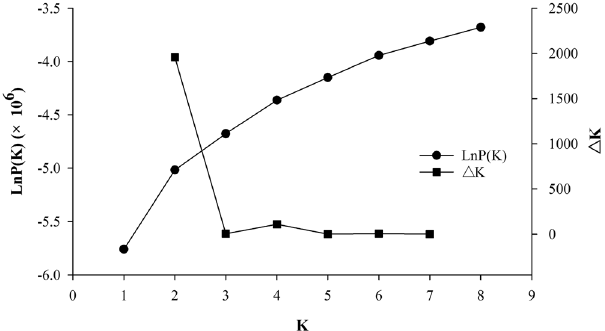
Figure 1. Likelihood distribution of subgroup based on model grouping method using the program STRUCTURE. Ln P (K) and ∆ K plotted as a function of the assumed number of subgroups ( K